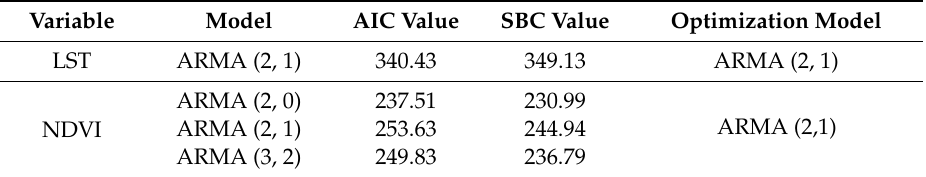
Table 2. LST and NDVI models.